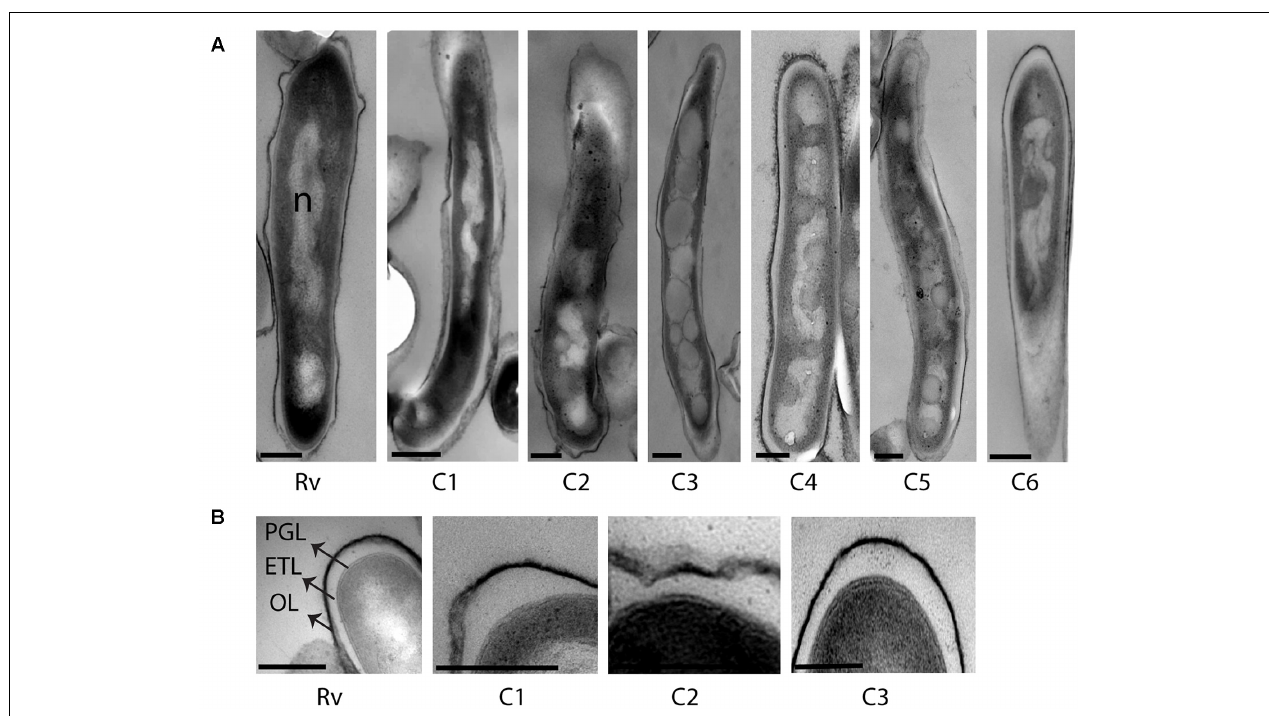
FIGURE 2 | Cellular ultrastructure of clinical M. tuberculosis strains under mid-log culture condition. (A) TEM images of H37Rv (Rv) and six clinical M. tuberculosis strains from mid-log culture (C1–C6). (B) TEM images of H37Rv and three clinical M. tuberculosis strains (C1–C3) with detailed ultrastructure of cell envelope layers in mid-log culture. OL, outer layer; ETL, electron transparent layer; PGL, peptidoglycan layer; ILI, intracytoplasmic lipid inclusions; n, nucleoid. Scale bar = 200